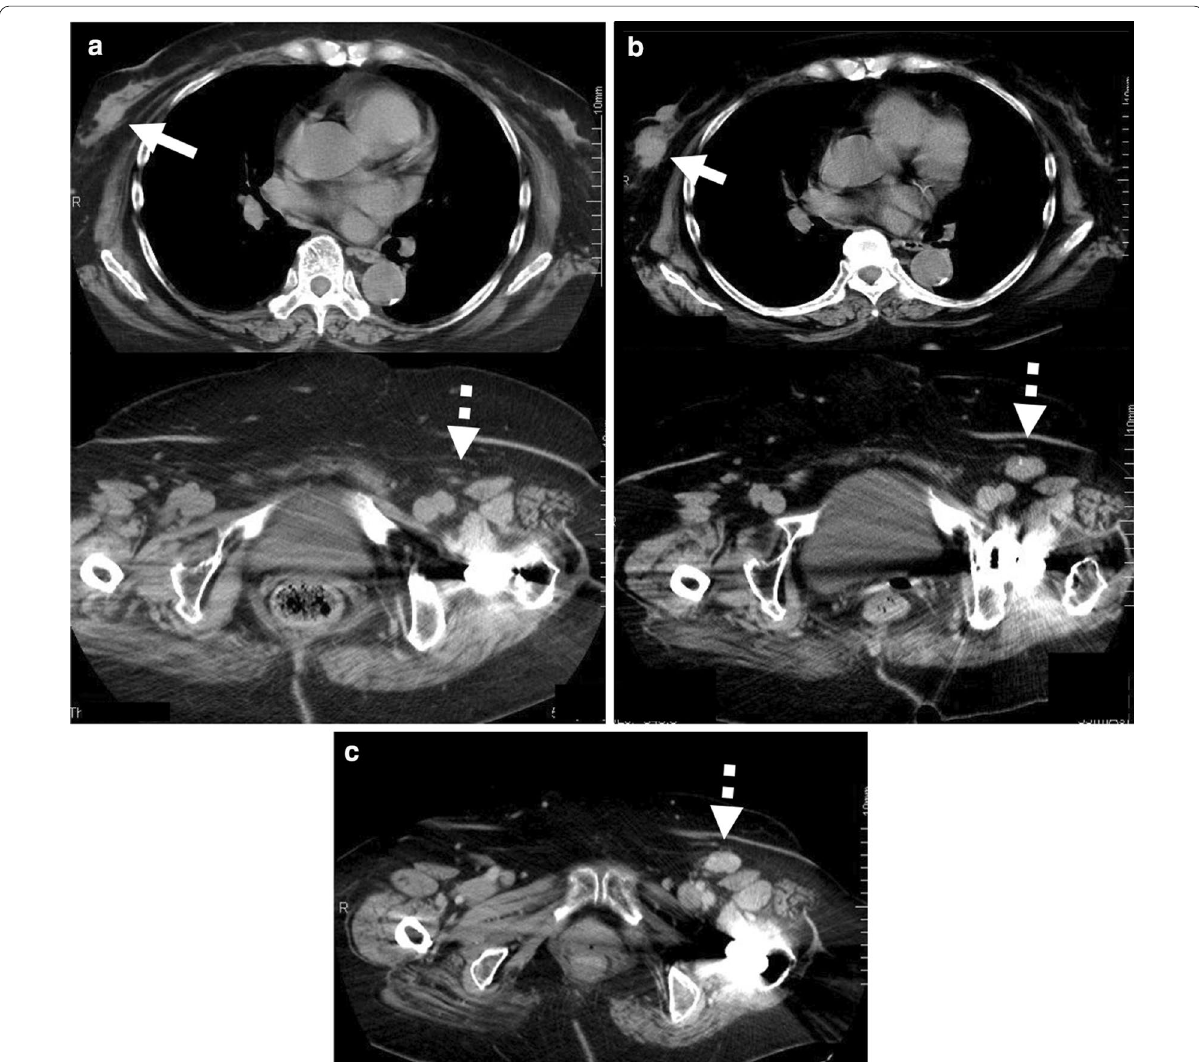
cancer operation: right breast tumor was getting to be apparent (arrow) in concordance with the left inguinal node swelling, 28 (dotted arrow) which had been overlooked. c The pelvic CT in 3 years after the breast cancer operation. As compared with the inguinal swelling shown in b (at the time of breast cancer surgery), the size of the nodes had still been dormant (dotted arrow). During these periods, adjuvant hormone therapy had been done in